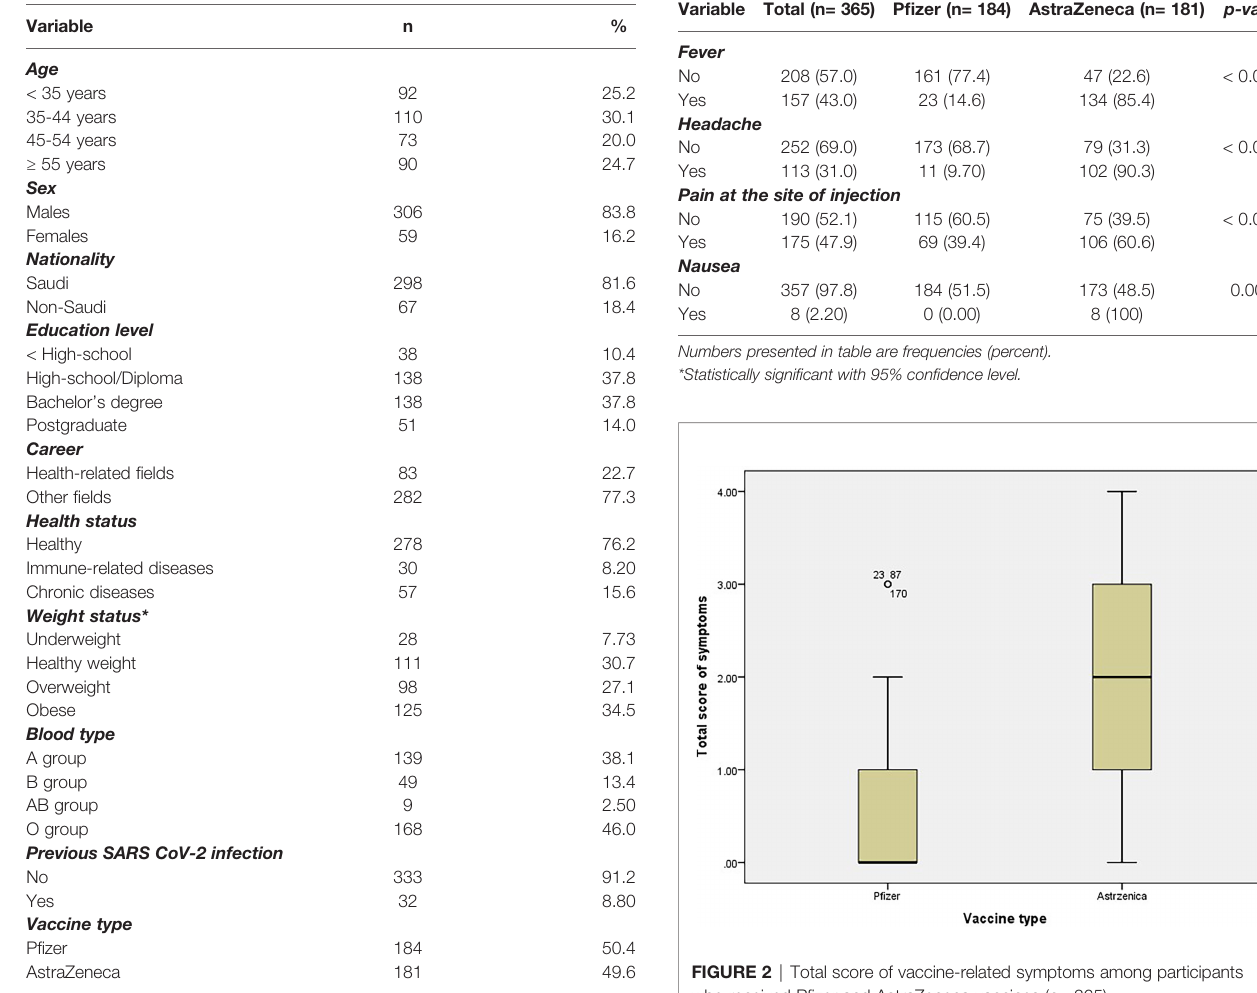
TABLE 2 | Vaccine-related symptoms reported by participants strati fi ed by type of vaccine.